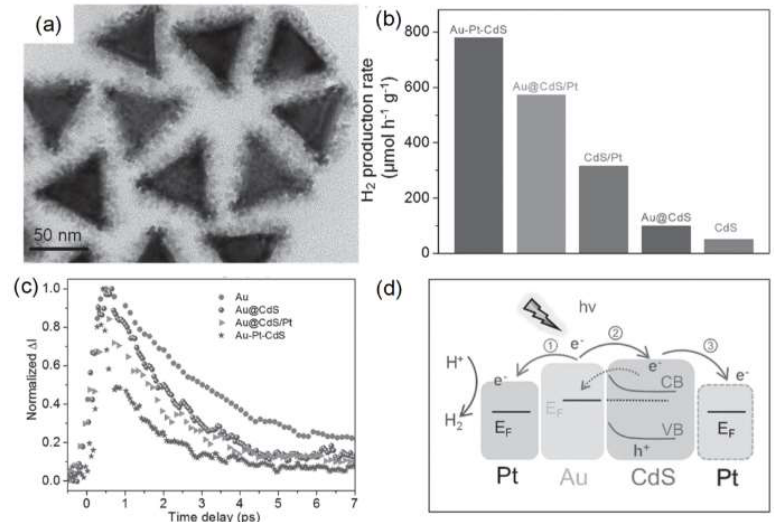
Figure 6. ( a ) TEM image of Au–Pt–CdS hybrids. ( b ) Photocatalytic hydrogen production of contrast samples. ( c ) Normalized time-resolved optical differential transmission of different samples. ( d ) Schematic illustration of the possible electron transfer process of Au–Pt–CdS. Copyright 2016